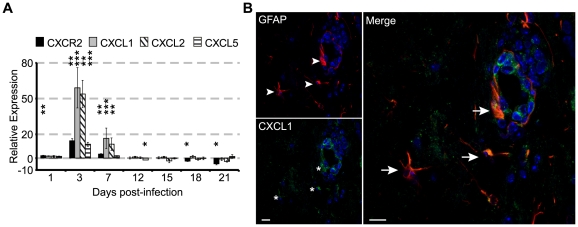
CXCR2 and ELR+ chemokines are expressed in the brain during acute JHMV infection.C57BL/6 mice were i.c. infected with 500 PFU JMHV and brains removed at defined times p.i. to determine the expression of transcripts specific for CXCR2, CXCL1,-2, and -5 using semi-quantitative PCR analysis (A). Data represent the fold-induction compared to sham-infected mice (n = 3–5 per time point, *p<0.05, **p<0.01, ***p<0.001). (B) Representative immunofluorescence staining of brain at day 3 p.i. for astrocytes (GFAP, red staining indicated by arrowheads) and CXCL1 (green staining, indicated by asterisks). Dual-positive cells (indicated by arrows within the merged image) were present surrounding the vessel wall as well as within the parenchyma. CXCL1 staining was enriched within the hippocampus at day 3 p.i. Bar  = 10 µm.